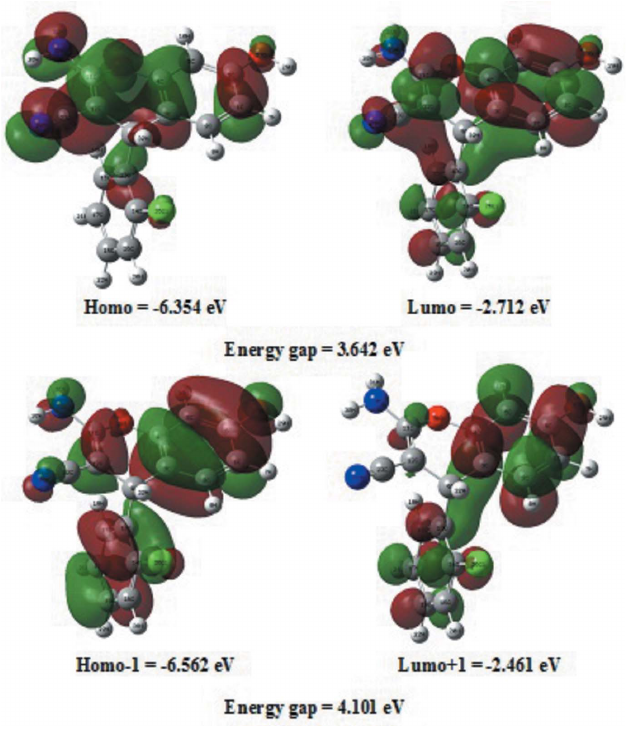
Figure 5 The frontier molecular orbitals (FMOs) of the title compound.